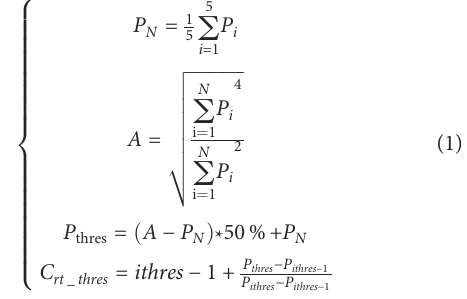
TABLE 2 Summary of the retracking strategies of three radar altimeters. Altimeters Ocean-like Quasi-specular